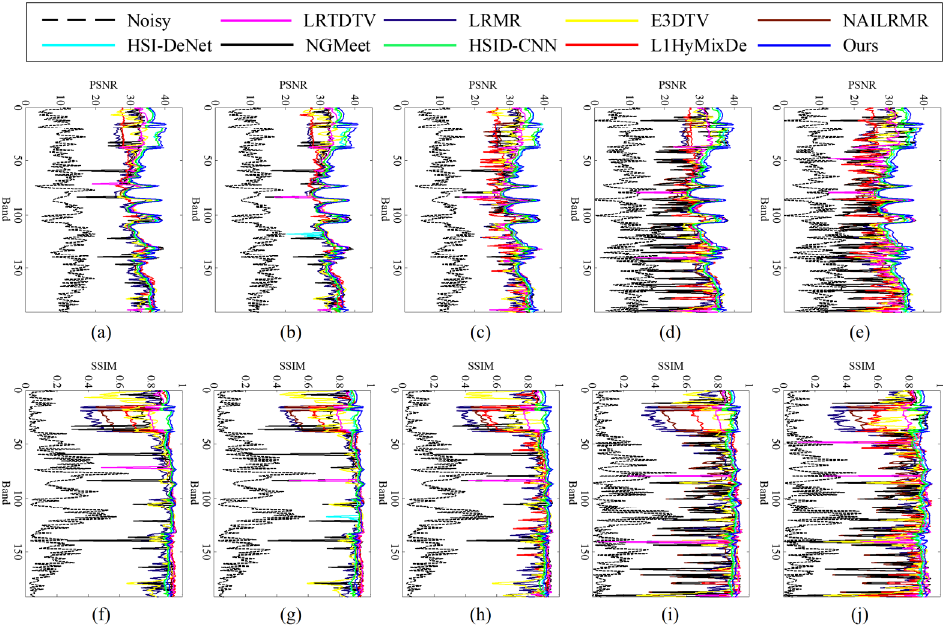
Figure 8. Band-wise PSNR values in the first row and band-wise SSIM values in the second row for denoised Washington DC data. Subfigures in ( a , f ), ( b , g ), ( c , h ), ( d , i ) and ( e , j ) correspond to Case 1, Case 2, Case 3, Case 4 and Case 5, respectively. Table 2. Quantitative assessment of different algorithms applied to Washington DC Mall data with mixture noise cases.